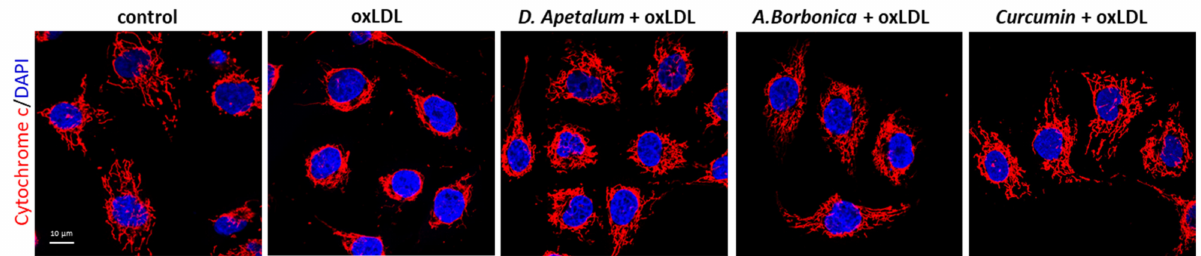
Figure 5. D. apetalum and A. borbonica extracts inhibit oxLDL-induced cytochrome C release from mitochondria to cytosol. Subconfluent serum-starved HMEC-1 cells were preincubated for 2 h with D. apetalum (25 µ M), A. borbonica (25 µ M) polyphenol-rich extracts or curcumin (10 µ M) before addition of oxLDLs (200 µ g apoB/mL) for an additional 24 h, control condition corresponds to untreated HMEC-1 cells (vehicle, PBS). Images are representative of immunofluorescence staining of cytochrome C (red) and cell nuclei (blue) stained with DAPI. Scale bar = 10 µ m.